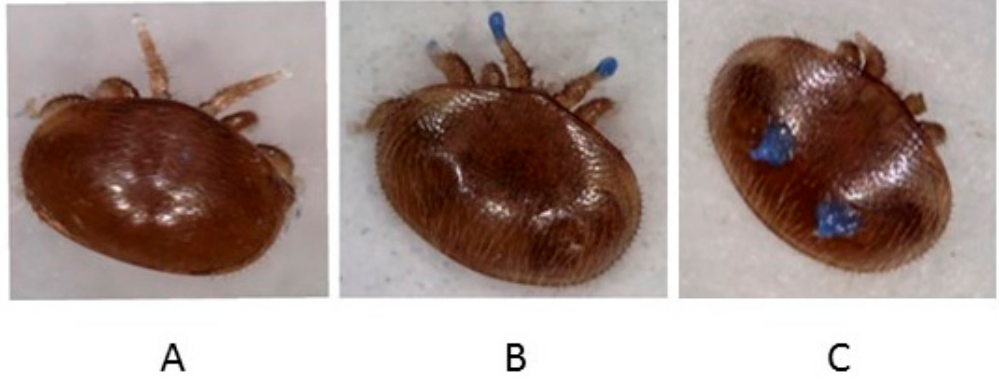
Figure 1. Varroa destructor used for the experiments: unvarnished female mite ( A ), mites with varnished foreleg ( B ) and mites with varnished idiosoma ( C ).